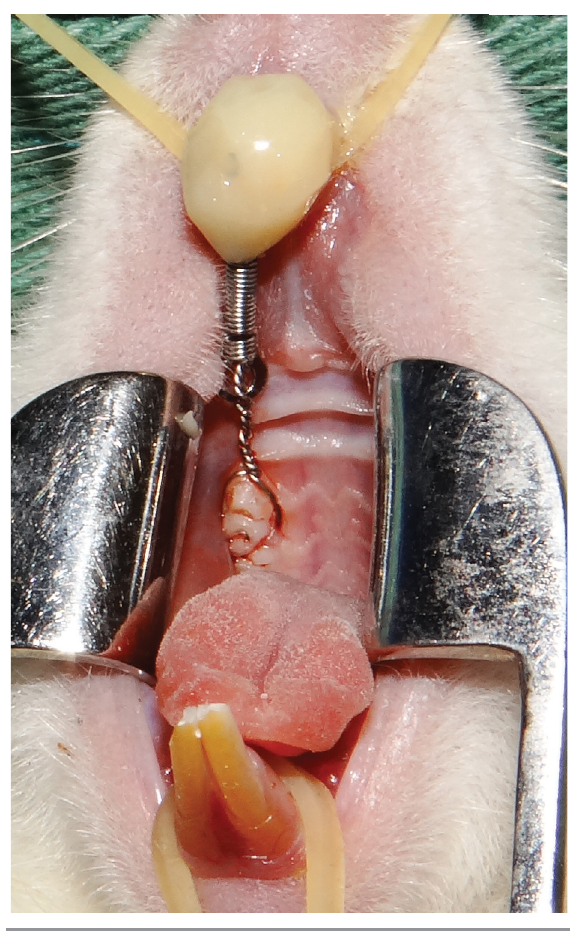
Figure 1. The installed orthodontic